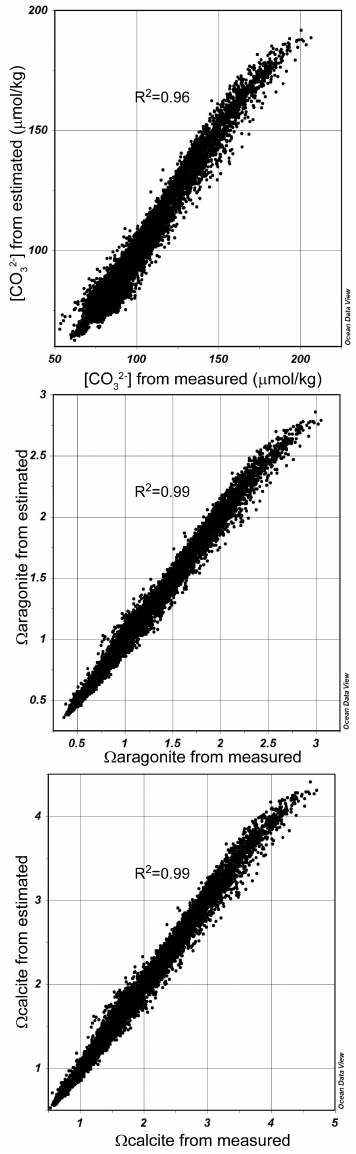
Fig. 6. Carbonate parameters [CO 2 − calculated with CO2SYS (Lewis and Wallace, 1998), using mea- sured versus estimated DIC and